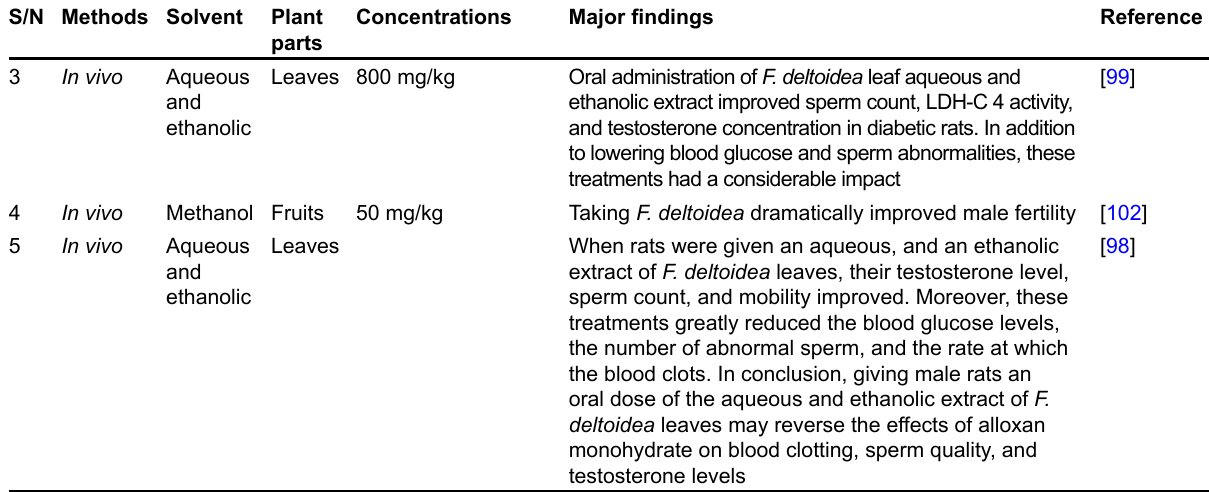
Table 6. Aphrodisiac activity of FD ( continued